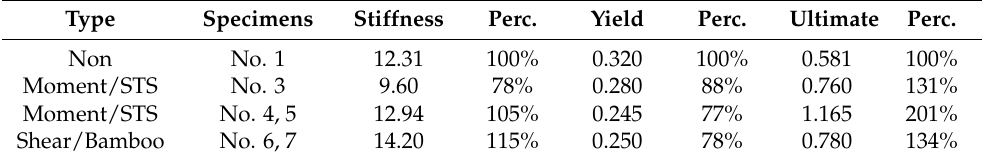
Table 6. Efficiency of preventing reinforcement for rotational behaviour *.